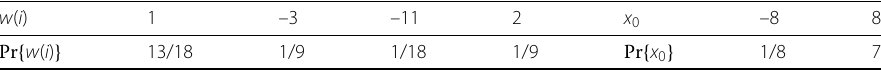
Figure 1 Bernoulli stochastic variable λ ( i ) when p ( i ) =